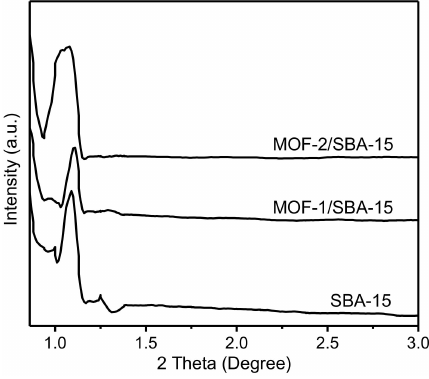
Figure 2. Small-angle X-ray diffraction (SXRD) patterns of spherical SBA-15, MOF-1/SBA-15 and